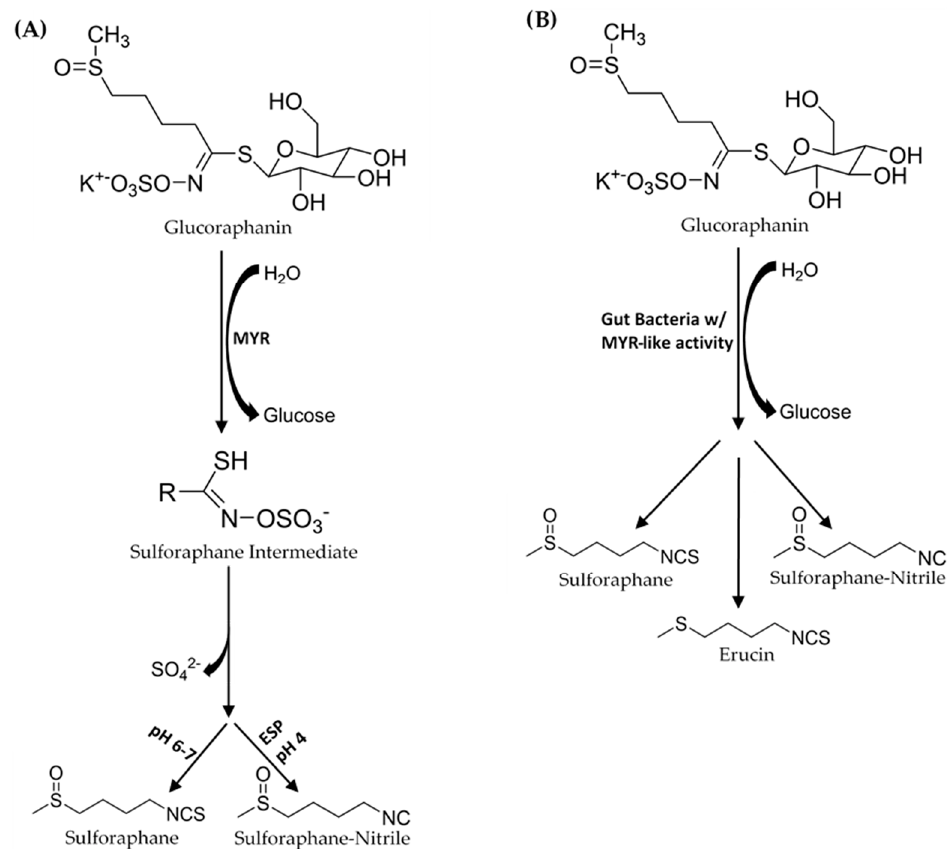
Figure 1. ( A ) In the mouth, myrosinase (MYR) converts glucoraphanin (GR) to an SR-O-sulfated thiohydroximate intermediate. Depending on pH conditions sulforaphane (SR) forms. SR-nitrile formation is preferred at low pH in the presence of epithiospecifier protein (ESP). ( B ) In the gut GR is converted to SR, SR-nitrile, and erucin by gut bacteria.